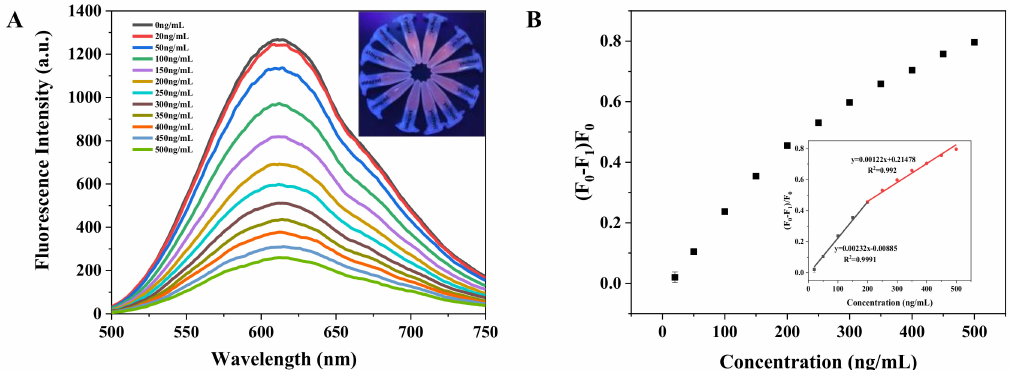
Figure 7. ( A ) Fluorescence spectra under various concentrations of paraquat. The inset picture is the fluorescence photo showing the detection of various concentrations of paraquat with GSH-AuNCs. ( B ) Calibration curve of paraquat sensing with different concentrations of 0, 5, 10, 20, 50, 100, 150, 200, 250, 300, 350, 400, 450, and 500 ng/mL, respectively. The inset shows the two linear fitting curves between the fluorescence-quenching efficiency [(F 0 − F 1 )/F 0 ] and the paraquat